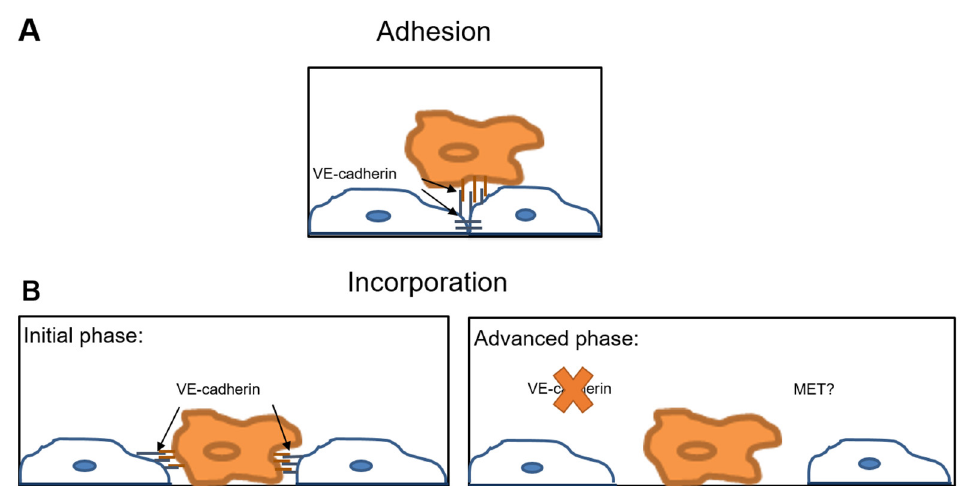
Figure 5. VE-cadherin interactions at the tumor cell-endothelial cell interface. Hypothetical model illustrating the VE-cadherin mediated interactions between tumor cells and endothelial cells during extravasation. ( A ) The adhesion of the tumor cell (orange) to the endothelial cell (blue) is mediated by the homophilic interaction between VE-cadherin on tumor cells and endothelial VE-cadherin. VE-cadherin facilitates tumor cell adhesion to the endothelium; ( B ) Initial incorporation phase: adherent tumor cells (orange) incorporate into the endothelium (blue). VE-cadherin might be involved in this initial phase of incorporation after mediating the contact between tumor and endothelial cells. Advanced phase: In the course of incorporation, endothelial cells (blue) downregulate VE-cadherin at the sites of contacts to the tumor cells (orange). The disruption of the VE-cadherin mediated endothelial cell contacts creates a gap in the endothelial layer through which tumor cells can transmigrate paracellularly. MET, mesenchymal-to-epithelial transition at the site of